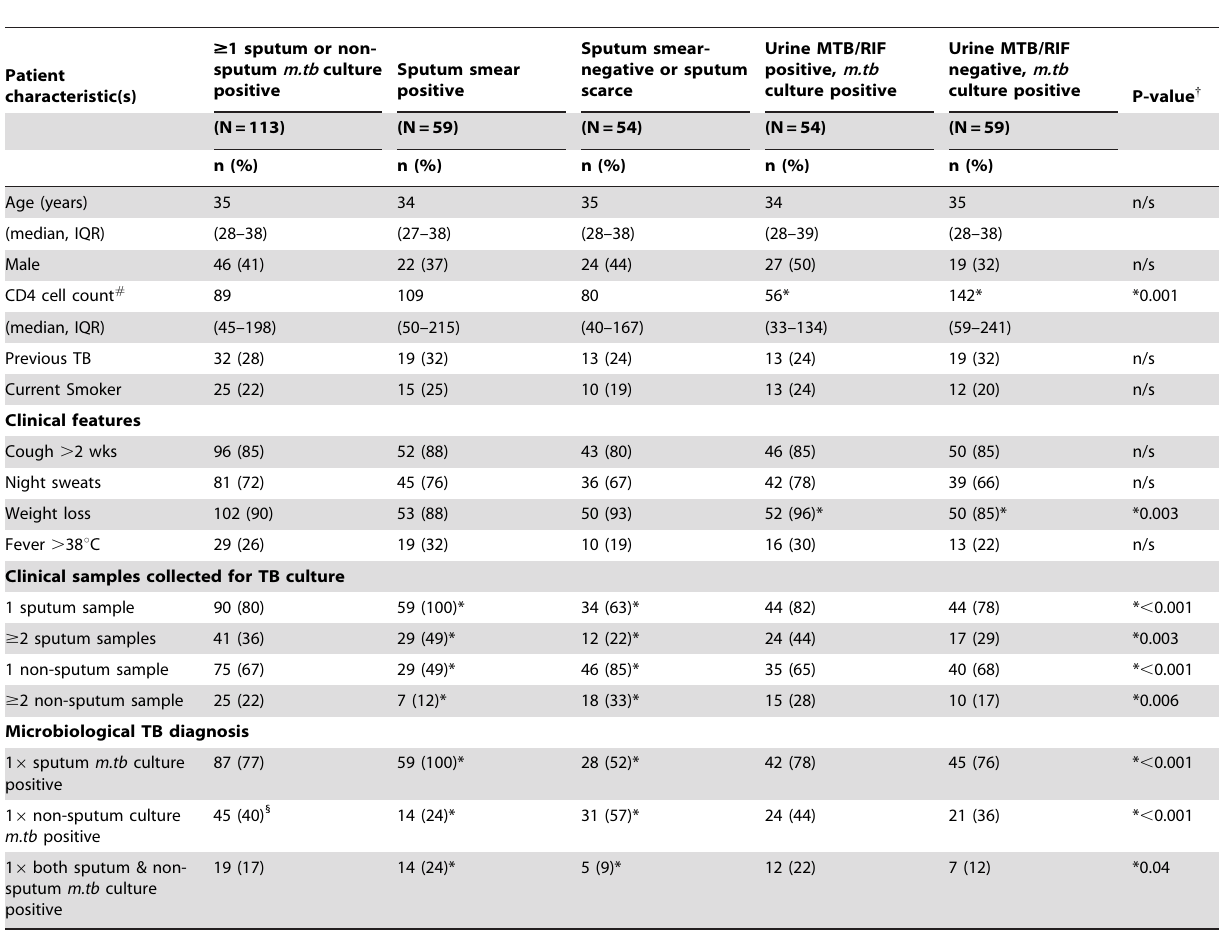
Table 1. Demographic, clinical and microbiological characteristics of m.tb culture positive and HIV-infected patients in the study population stratified by sputum smear microscopy and urine MTB/RIF